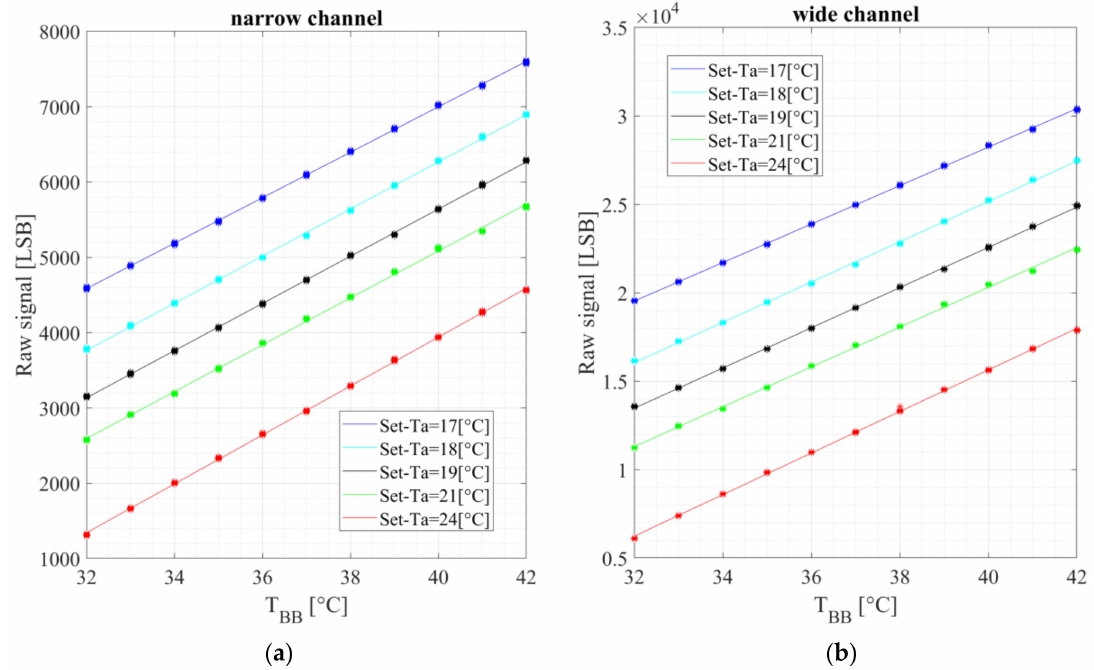
Figure 9. The measured signal in the lab as a function of the object temperature (or blackbody temperature) for different ambient temperatures measured by the air condition (Ta); The dots are the measured raw data, and the lines are the linear fit: ( a ) narrow channel bandpass 8–14 µ m; ( b ) wide channel bandpass 5.5–13.5 µ m.